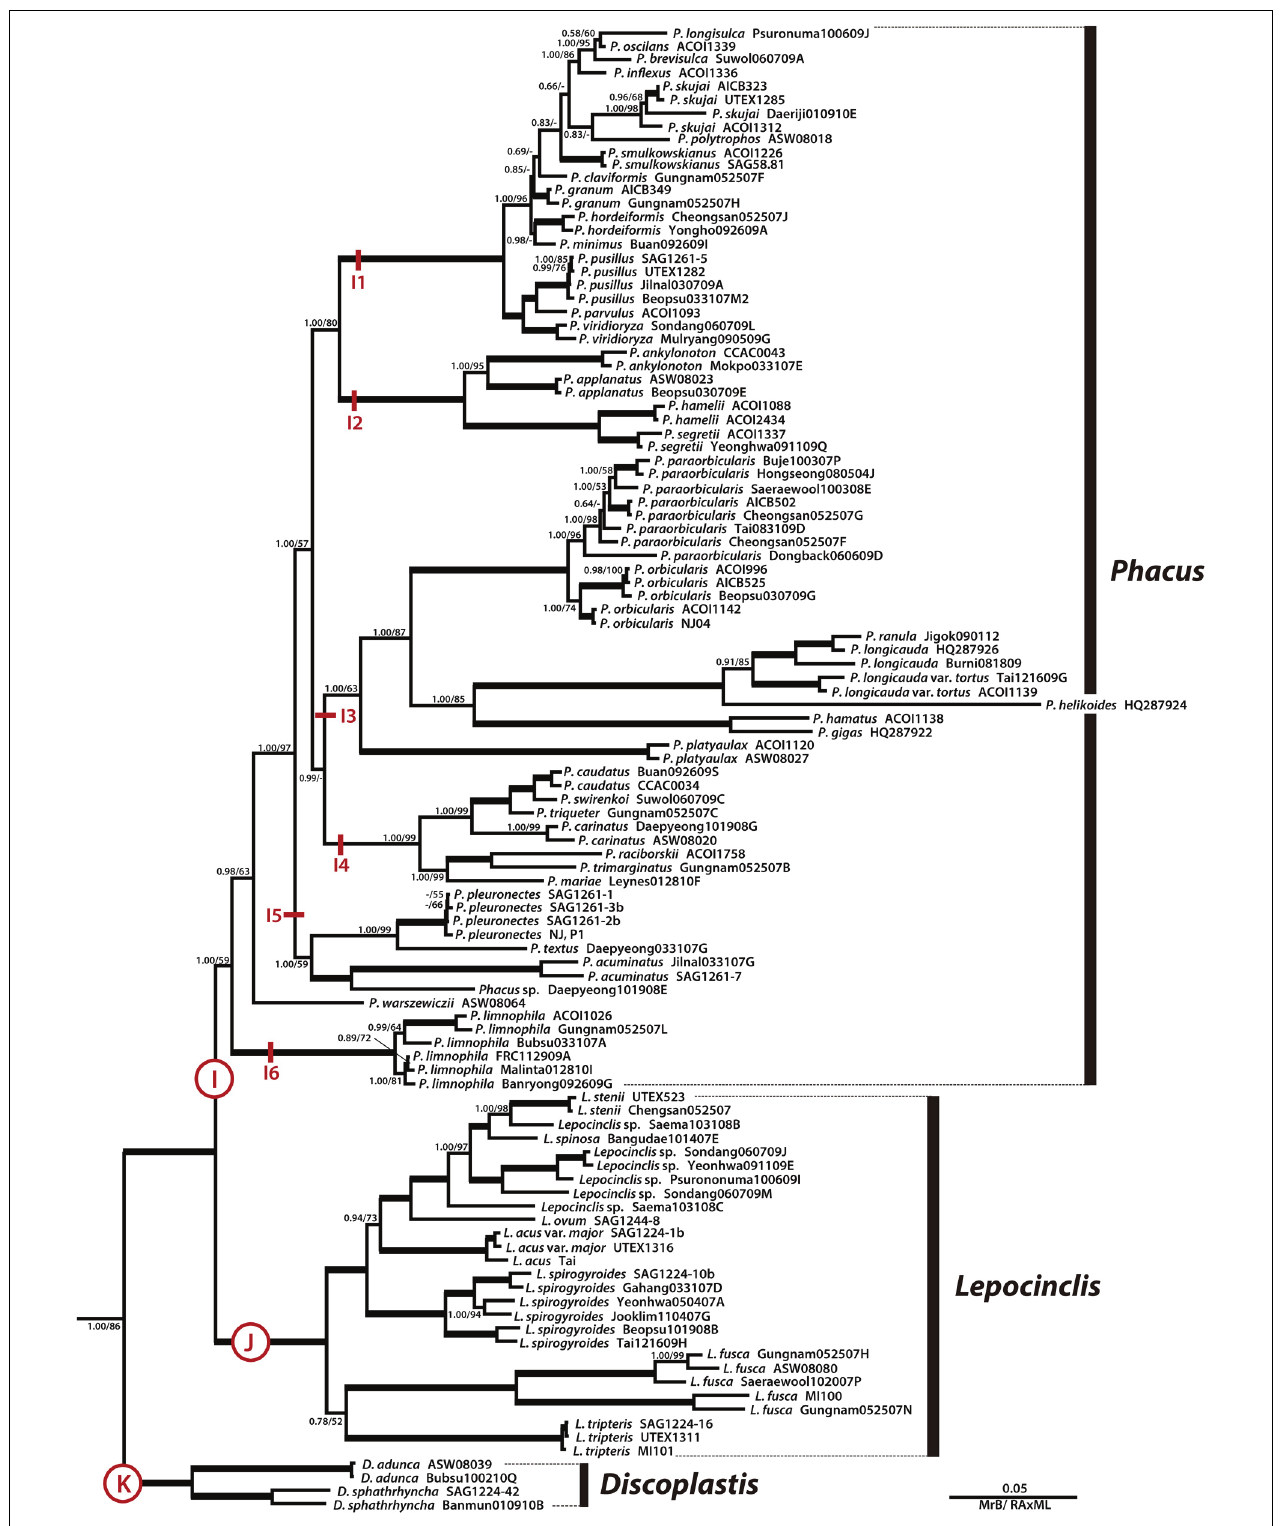
FIGURE 3 | A detailed Bayesian tree for the family Phacaceae of Figure 1. The numbers on each node represents posterior probabilities (left) and bootstrapping values (right) . The bold branches indicate strongly supported values (pp = 1.00 and ML = 100%).